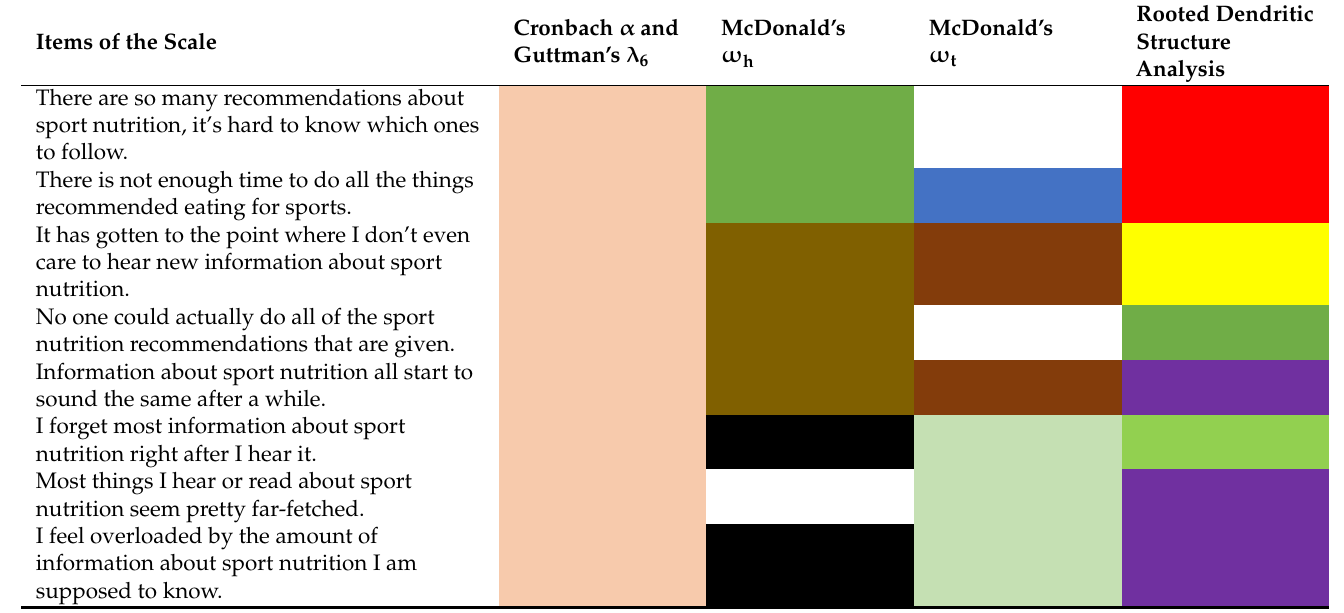
Table 14. Patterns of connections between items, determined by different methods (same colors indicate similarity).